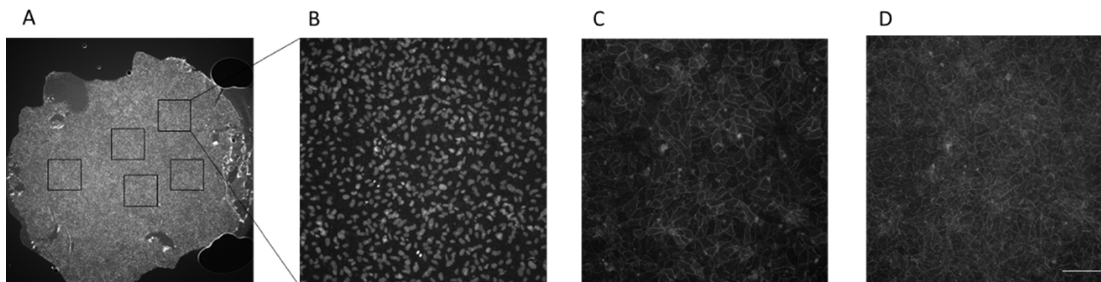
Figure 2. Automated imaging of the filter. Endothelial cells either grown on polycarbonate (PC) Transwell filter, polyester (PE) Transwell filter or on glass slide were stained and analyzed by automated imaging. First, the whole filter/slide area was imaged in 2× magnification. 4′,6-Diamidin-2-phenylindol (DAPI) staining was used to find focal plane ( A ). 5 randomly selected areas (squares) were further imaged with a 20× objective with excitation wavelengths of 385 nm ( B , DAPI ), 555 nm ( C , Alexa 555 ) and 647 nm ( D , Alexa 647 ). Grey scale pictures from PC filter are shown for all channels. Scale bar = 100 µm.